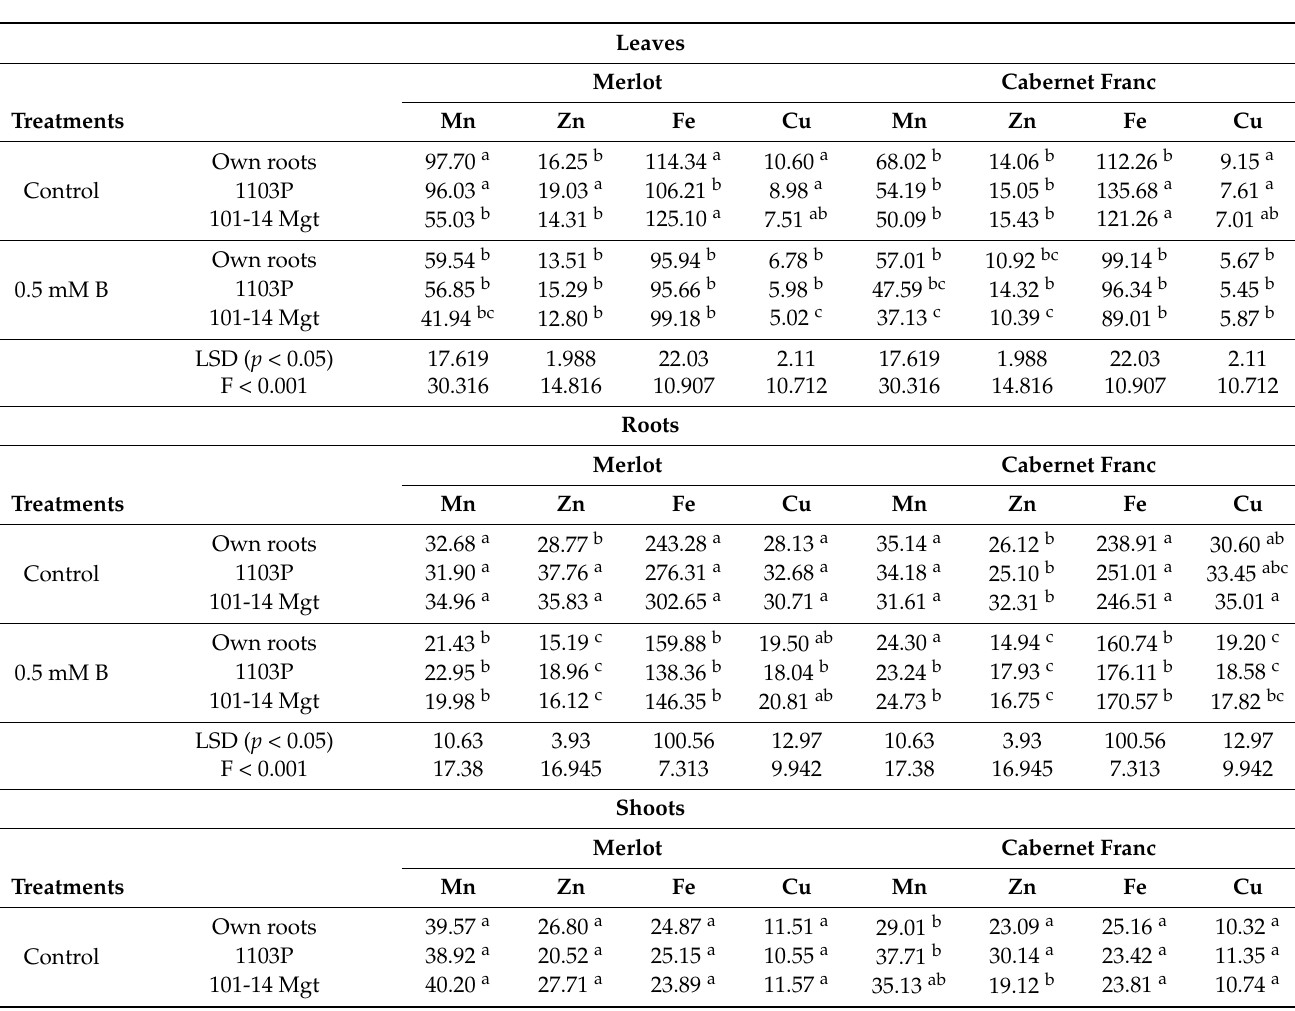
Table 5. The effect of boron toxicity on Mn, Zn, Fe and Cu (mg kg − 1 ) concentration in different parts of Merlot and Cabernet Franc vines on their own roots or grafted onto 1103P and 101-14 Mgt rootstocks. Leaves Merlot Cabernet Franc